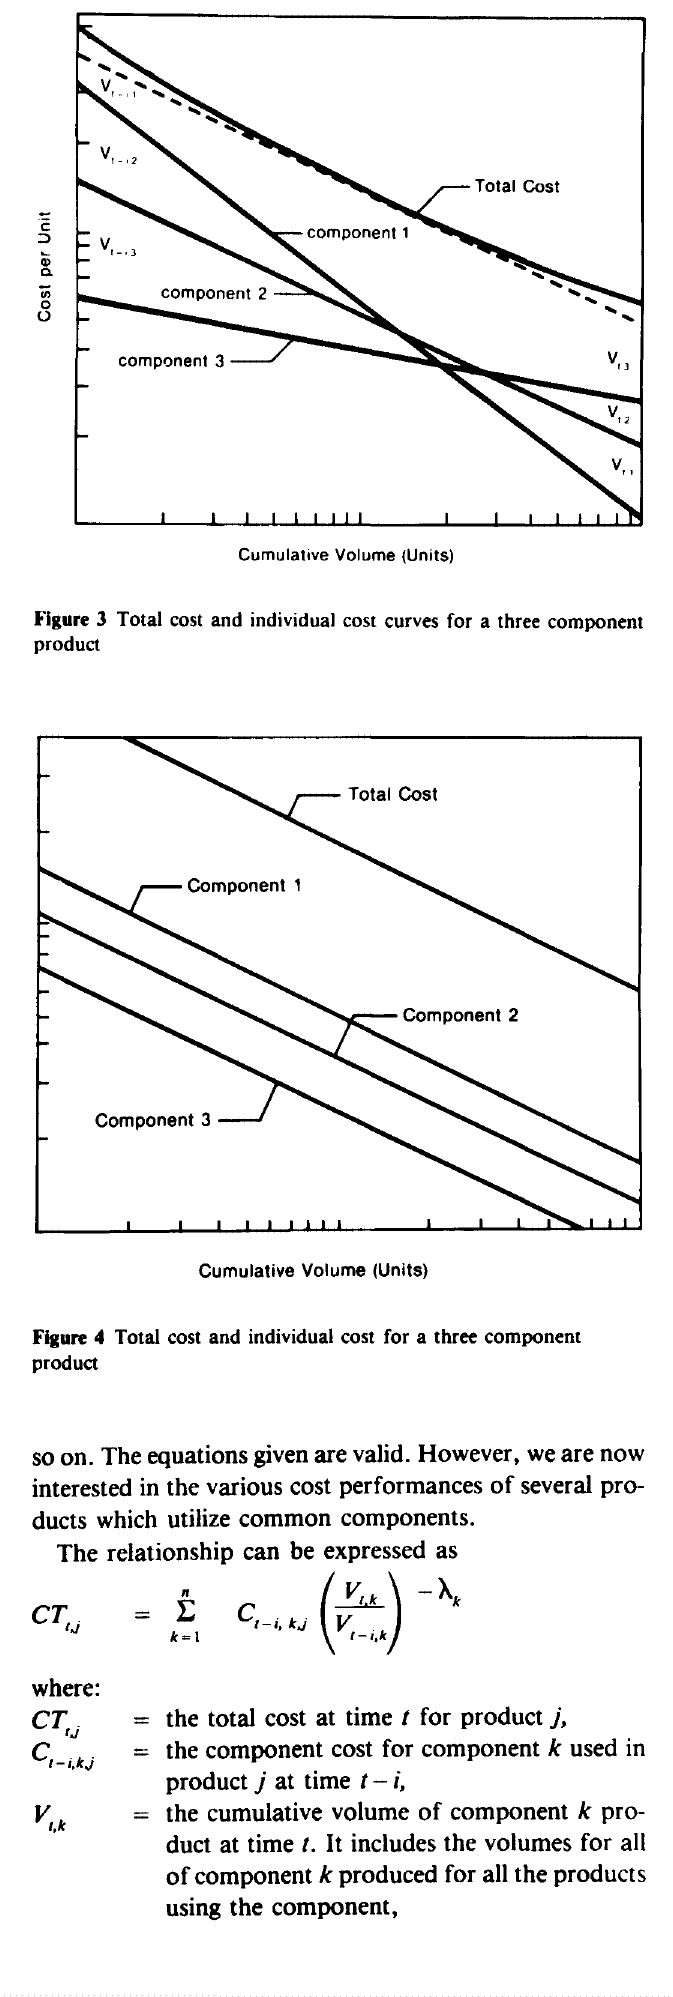
Figure 4 Total cost and individual cost for a three component